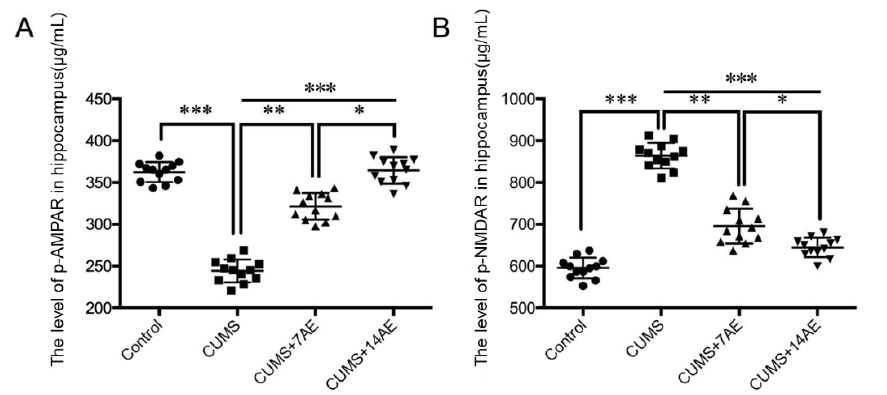
Figure 4. Effects of aerobic exercise on p-AMPAR ( A ) and p-NMDAR ( B ) in hippocampus of CUMS-induced depression rats. * p < 0.05; ** p < 0.01; *** p < 0.001; CUMS: chronic unpredictable mild stress; 7AE: Aerobic exercise for 7 days; 14AE: Aerobic exercise for 14 days.